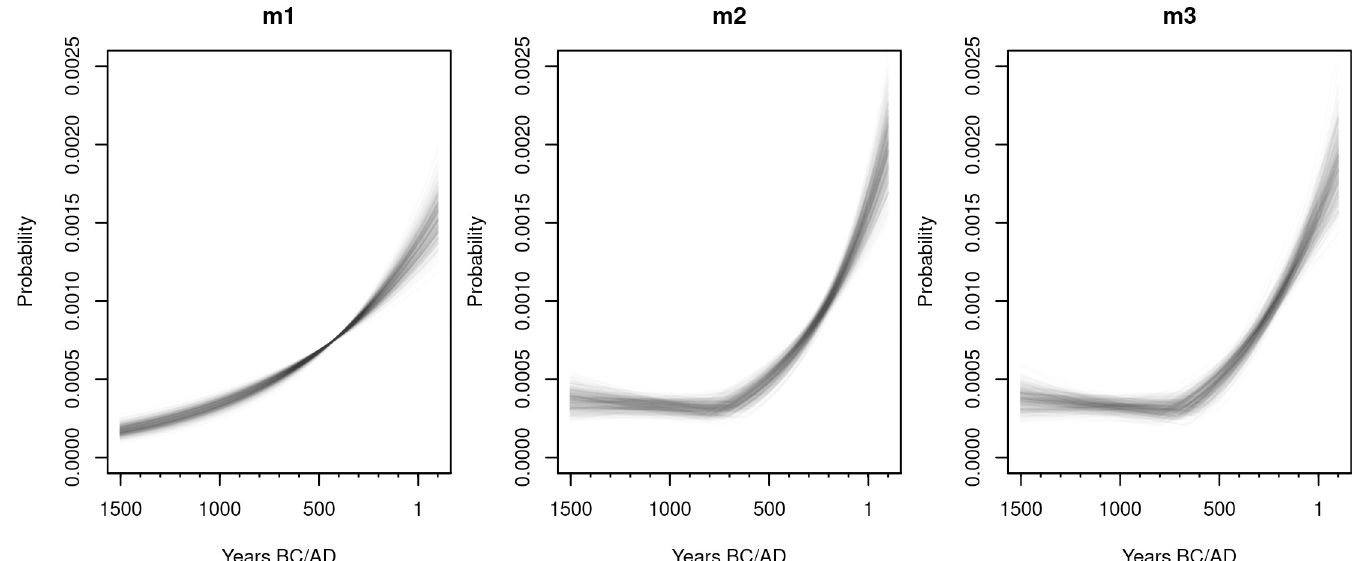
Fig 8. Spaghetti plot with the 500 posterior samples of the fitted models.